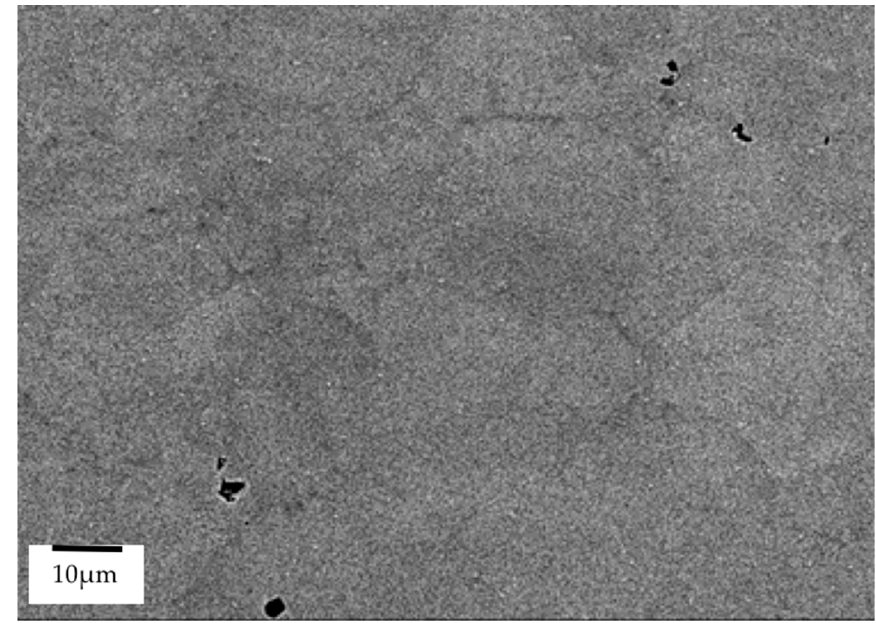
Figure 5. FEG-SEM of pores in as-received new generation nickel-based superalloy .